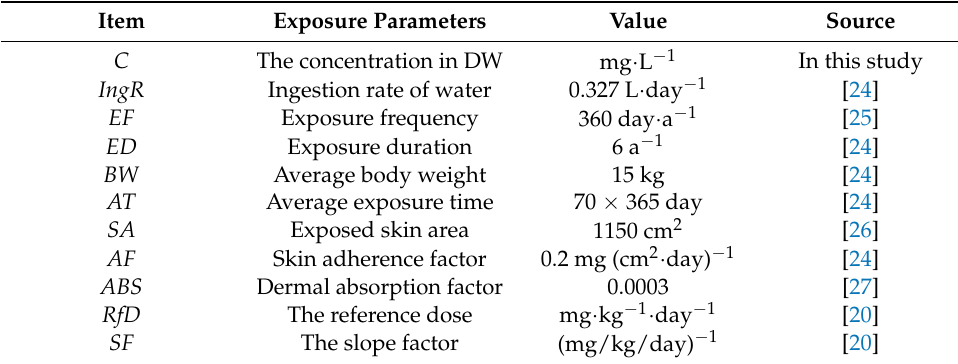
Table 1. Parameters for HMs exposure in DW for children.